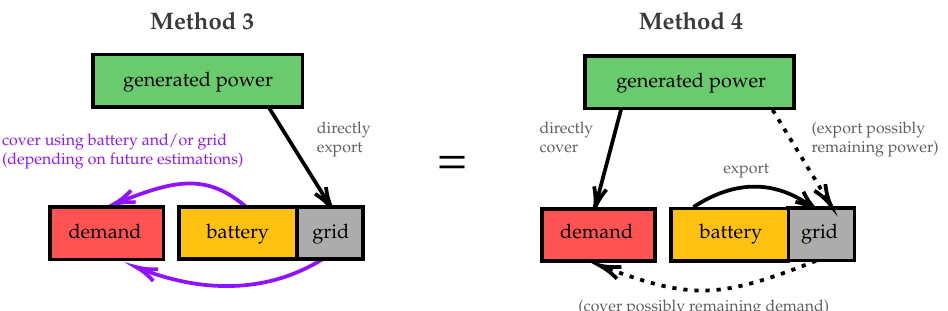
Figure 5. Scenario in which generated power is directly exported to the grid. Instead of directly exporting the generated power, it can be shown to be equally effective to directly cover demand using generated power while still being able to export and import the same amount of energy (thus equal profit and loss) and discharge the battery